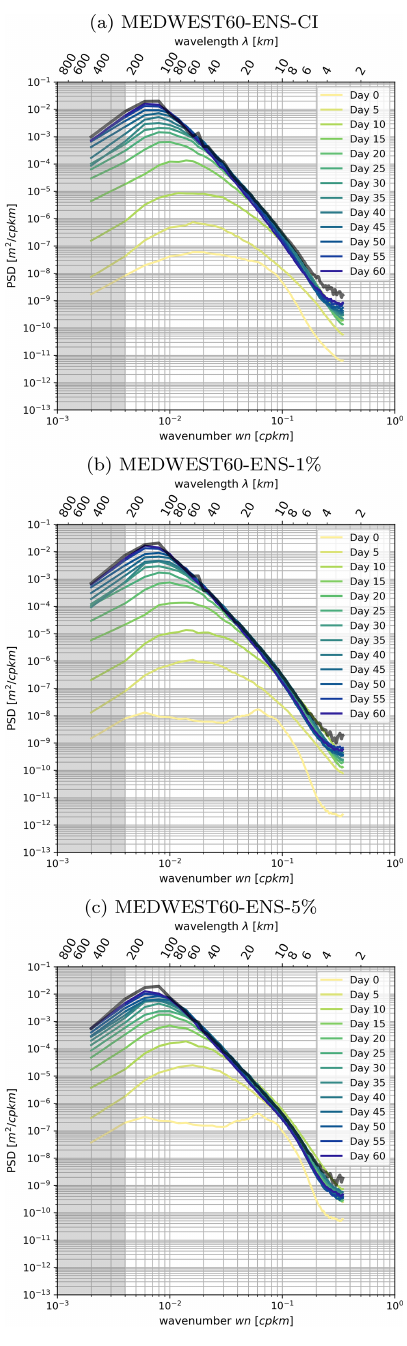
Figure 7. Ensemble-mean wavenumber power spectrum density (PSD) of the hourly SSH at day 60 (black thick line) compared to the mean PSD of the forecast error in experiments (a) ENS-CI, (b) ENS-1% and (c) ENS-5%. The forecast error is assessed as the difference in the hourly SSH fields between all pairs of members in the given ensemble, and the mean is taken of the PSDs of all the 20 × 19 permuted pairs at each time (time increasing from yellow to blue colors); see text in Sect. 4.3 for more details. The time lag labeled “Day 0” is taken after 1h of the experiment. The gray shad- ing indicates where the spatial scales are not fully resolved within the considered region (scales larger than L/ 2 ∼